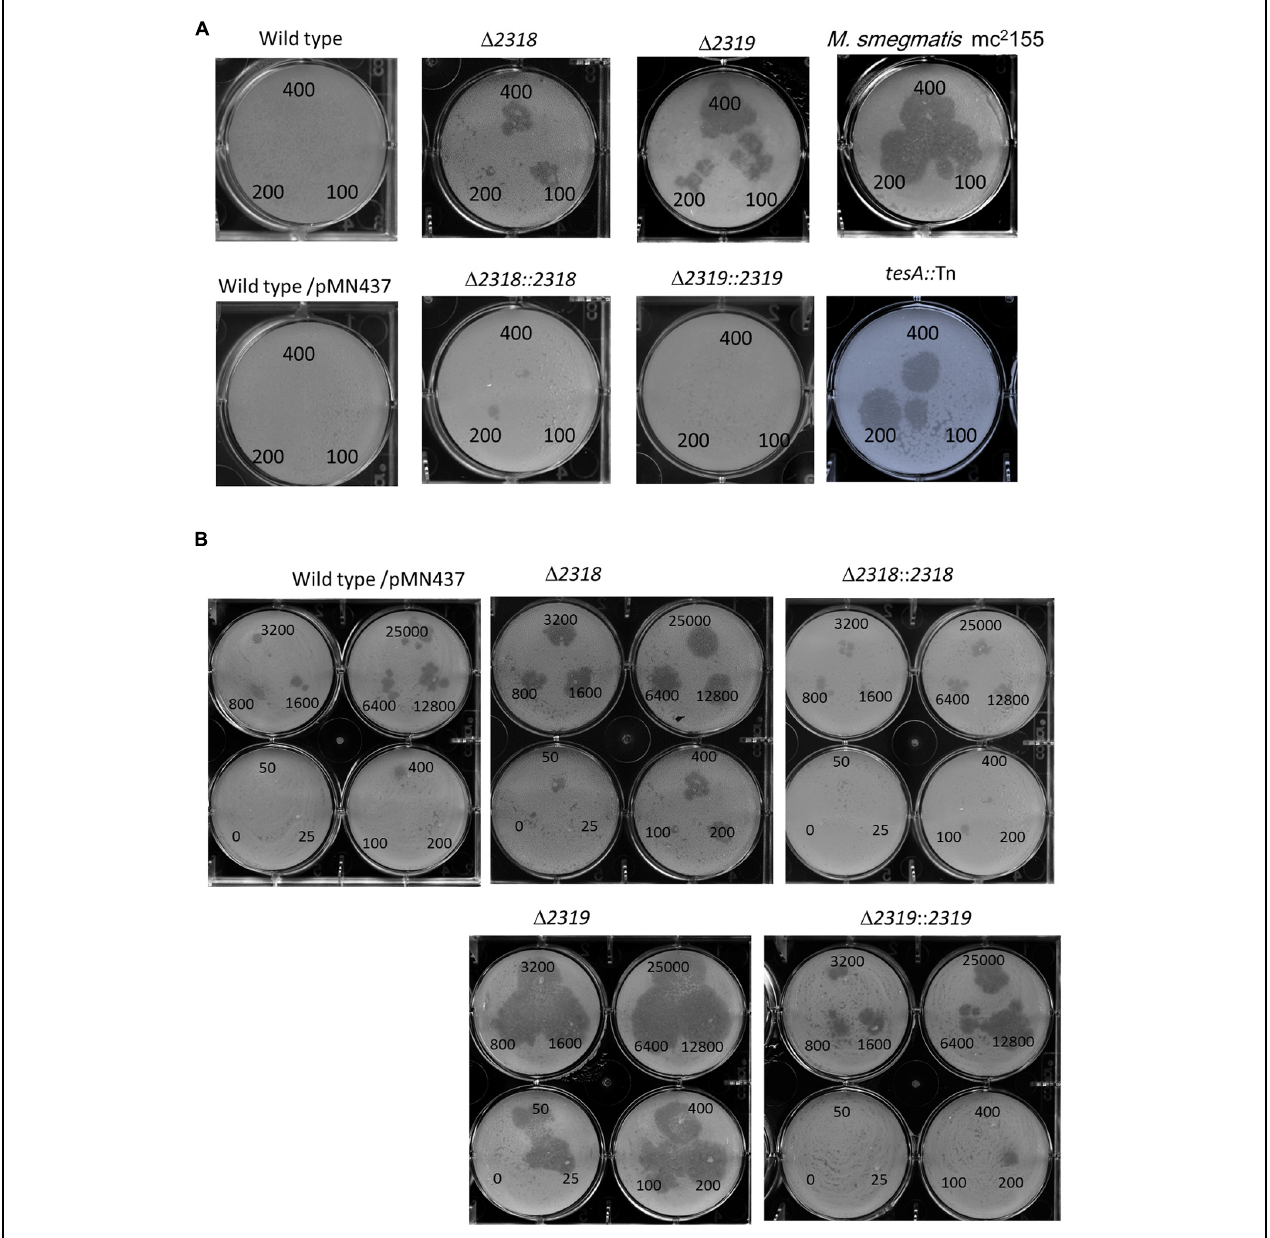
FIGURE 4 | Phenotypic confirmation and quantitative analysis of deletion mutants and complementation strains. (A) The Dictyostelium phagocytosis plaques on bacterial lawn with the wild-type, deletion, and complementation strains. A total of 400, 200, or 100 Dictyostelium cells could form a clear phagocytosis plaque on a bacterial lawn with (cid:2) 2318 and (cid:2) 2319 mutants but not with the wild-type, (cid:2) 2318 :: 2318 and (cid:2) 2319 :: 2319 strains. M. smegmatis mc 2 155 and tesA ::Tn mutant (known as an avirulent M. marinum mutant) were served as controls. Comparable results were observed in wild type vs. wild type/pMN437, demonstrating that the transfer of pMN437 into M. marinum did not affect phagocytic plaque formation. (B) Quantitative analysis of virulence of wild-type, deletion, and complementation strains. Different amounts of Dictyostelium (0–25000 cells) were used to quantify the virulence of the M. marinum wild-type strain, the deletion mutants ( (cid:2) 2318 and (cid:2) 2319 ), and the complementation strains ( (cid:2) 2318 :: 2318 and (cid:2) 2319 :: 2319 ). Fifty cells and twenty-five Dictyostelium cells could form a clear phagocytic plaque on bacterial lawn with the (cid:2) 2318 and (cid:2) 2319 mutants, respectively, but not with the wild-type, (cid:2) 2318 :: 2318 and (cid:2) 2319 :: 2319 strains. The virulence phenotype was restored ( > 400 cells) in the complementation